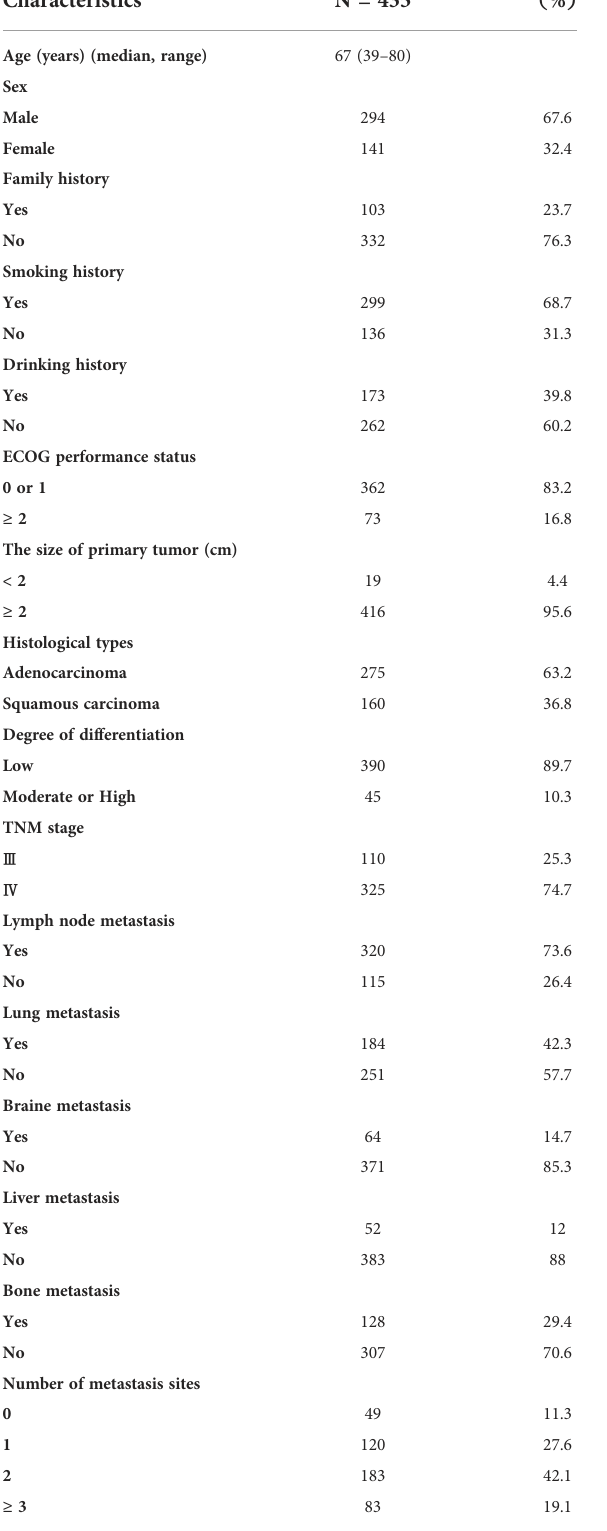
TABLE 1 The baseline characteristics of